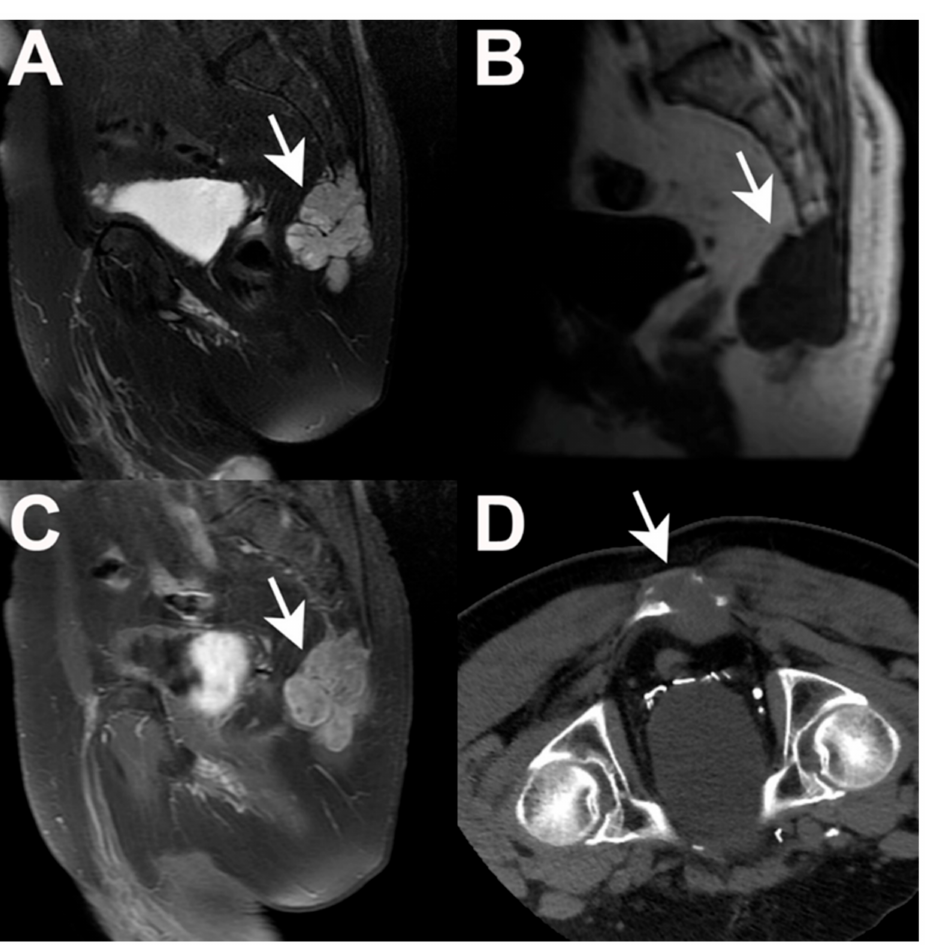
Figure 2. Radiographic appearance of a sacral chordoma. Sagittal T2-weighted MRI ( A ) demon- strating predominant hyperintensity with hypointense septations, scattered calcification and micro- hemorrhage. Sagittal T1 pre-contrast MRI ( B ) demonstrating diffuse hypointense signal. Sagittal T1-weighted post-contrast MRI ( C ) demonstrating marked, heterogenous contrast